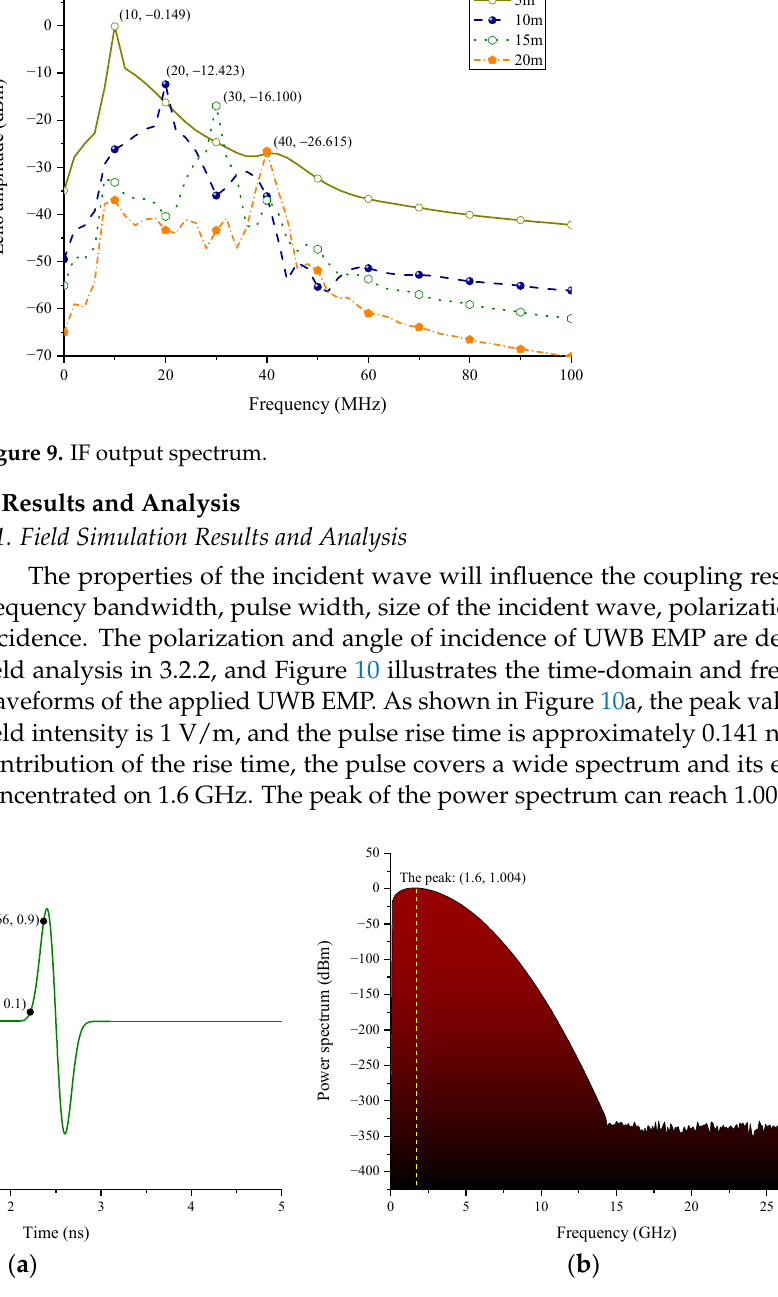
Figure 10. Time-domain waveform and the frequency-domain waveform of UWB EMP. ( a ) Time- domain waveform of UWB EMP; ( b ) frequency-domain waveform of UWB EMP.